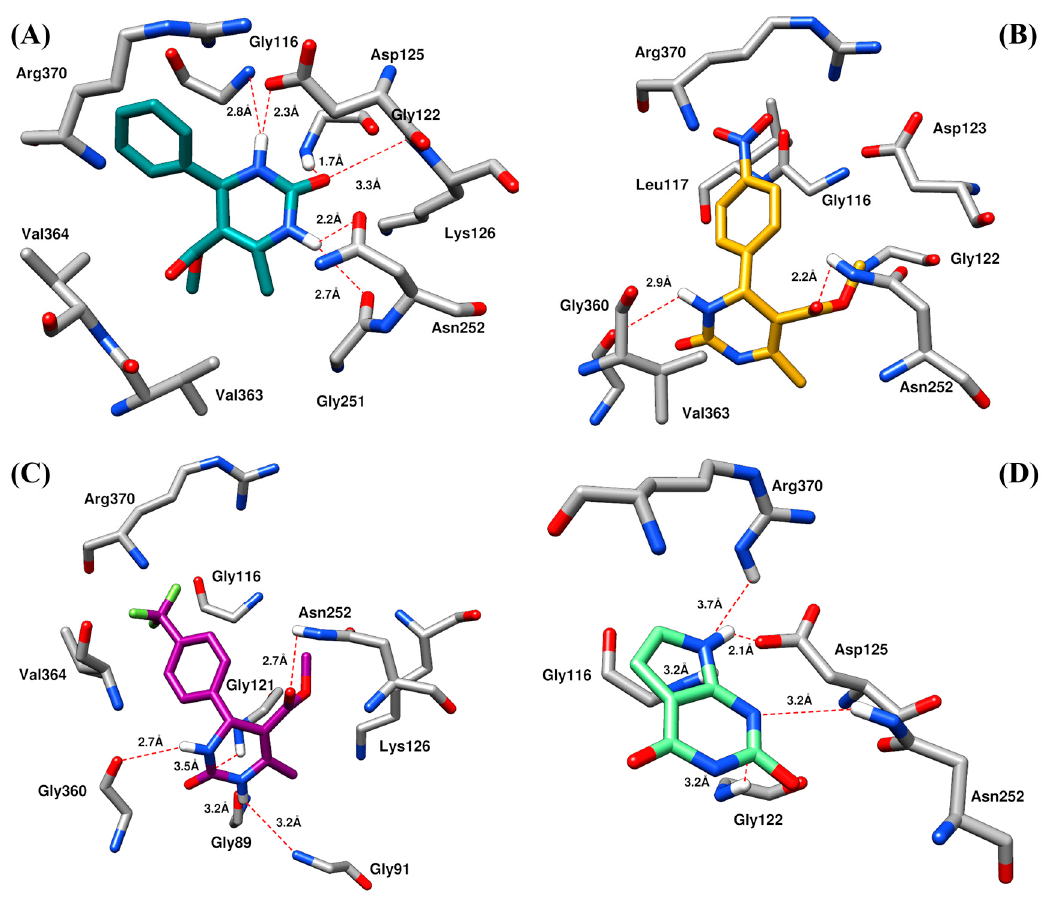
Figure 4. The binding mode of ( A ) compound 1 ( B ) compound 12 ( C ) compound 33, and ( D ) 7-deazaxanthine with the allosteric site of TP enzyme predicted by site map analysis. The TP residues are shown in dark grey sticks, while ligands are shown in different color sticks. The red dotted lines represented the hydrogen bond contacts.